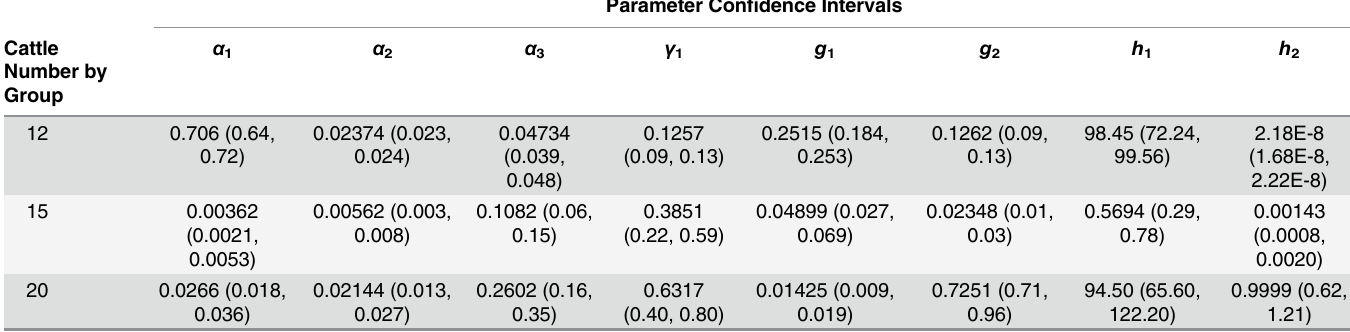
3. Test for identifiability of the fitted parameters for the predicted biological interactions through testing for their collinearity (multi-collinearity occurs when independent variables are so highly correlated that it becomes difficult to distinguish their individual influences on the response variable). The parameter set with the smallest collinearity index is determined q by ¼ ð 1 = and dimensionless sensitivity matrix of model parameters p